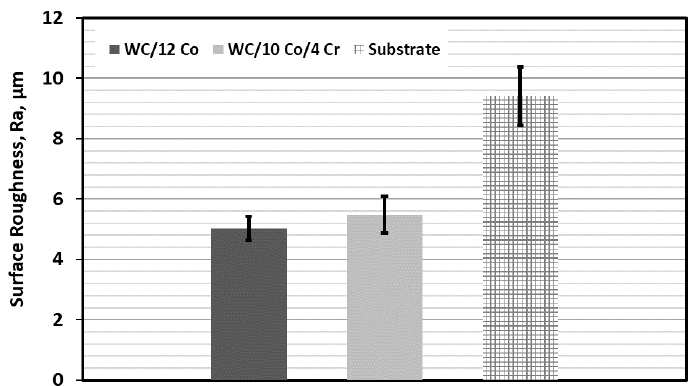
Figure 6. The roughness of as-coated surface compared to that of the substrate.